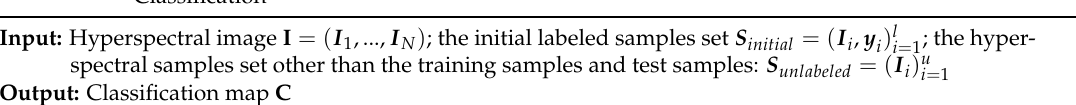
Algorithm 1: Sparse Representation-based Sample Pseudo-Labeling (SRSPL) for Hyperspectral Image